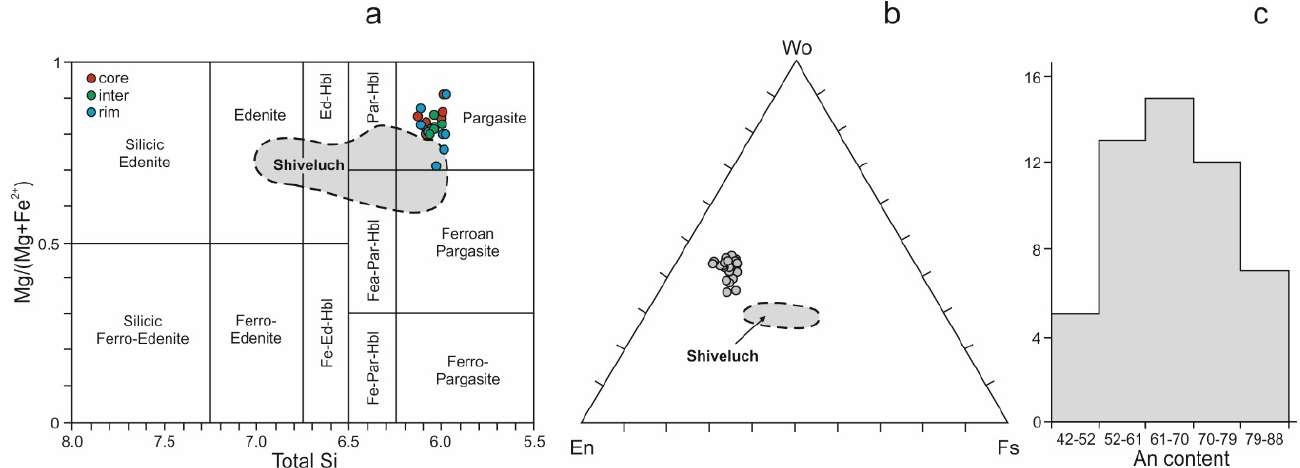
Figure 6. Chemical composition of phenocrysts in northern Kamchatka adakites: ( a ) amphibole, ( b ) clinopyroxene and ( c ) plagioclase. Field of mineral compositions from the Shiveluch adakites is after [175]. Table 4. Representative mineral compositions (wt.%) of Northern Kamchatka adakites.